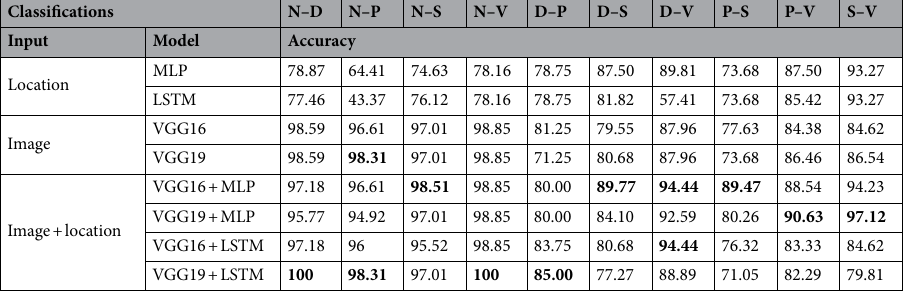
Classifications